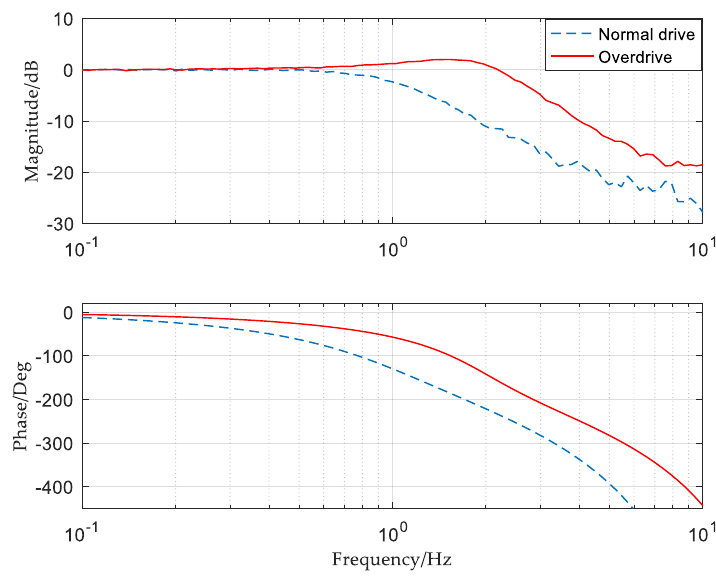
Figure 9. Closed loop characteristics under different driving conditions.